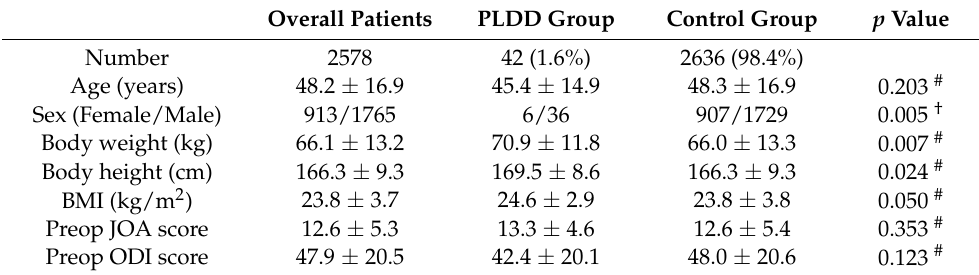
Figure 1. Flowchart of the current study. Table 1. Overall